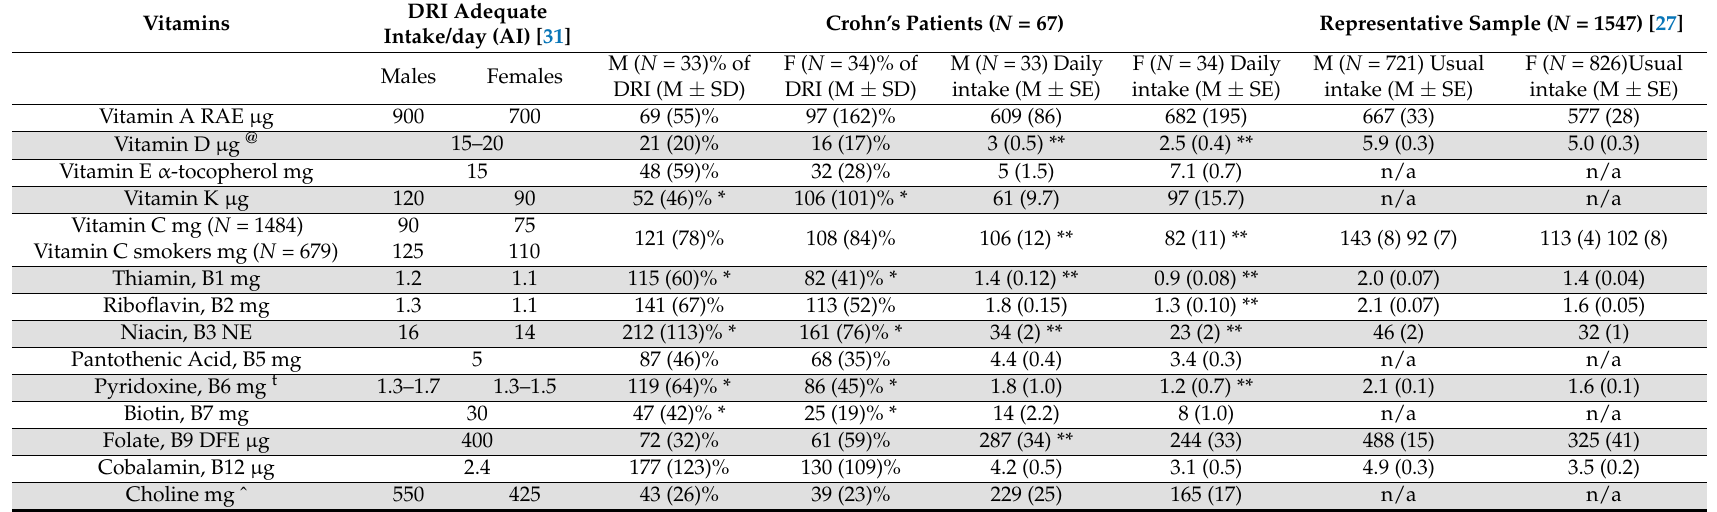
Table 3. Vitamin intake compared to a representative